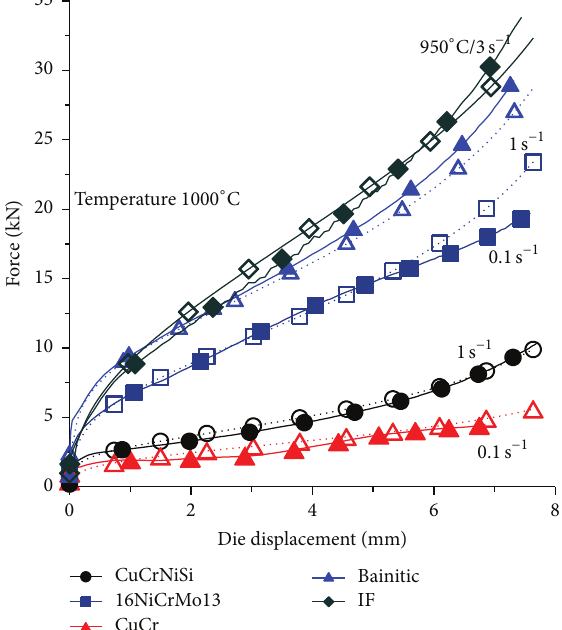
Figure 19: Selected examples of comparison of the loads measured in the tests (solid lines) and calculated by the FE code (dotted lines) with flow stress model (3) with coefficients determined by the inverse analysis with metamodel.